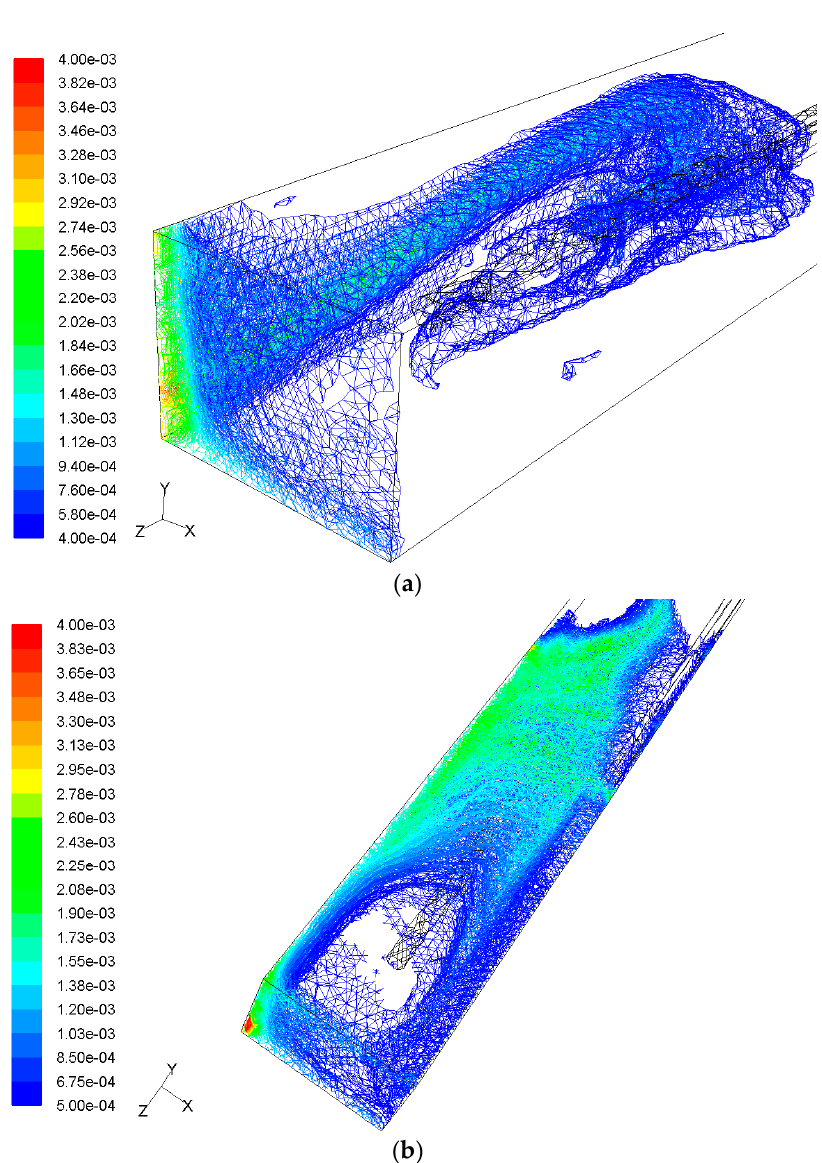
Figure 14. Coal dust concentration distribution near heading face under long blowing and short suction ventilation system. ( a ) Total dust concentration distribution (kg/m 3 ); ( b ) respirable dust concentration distribution (kg/m 3 ).